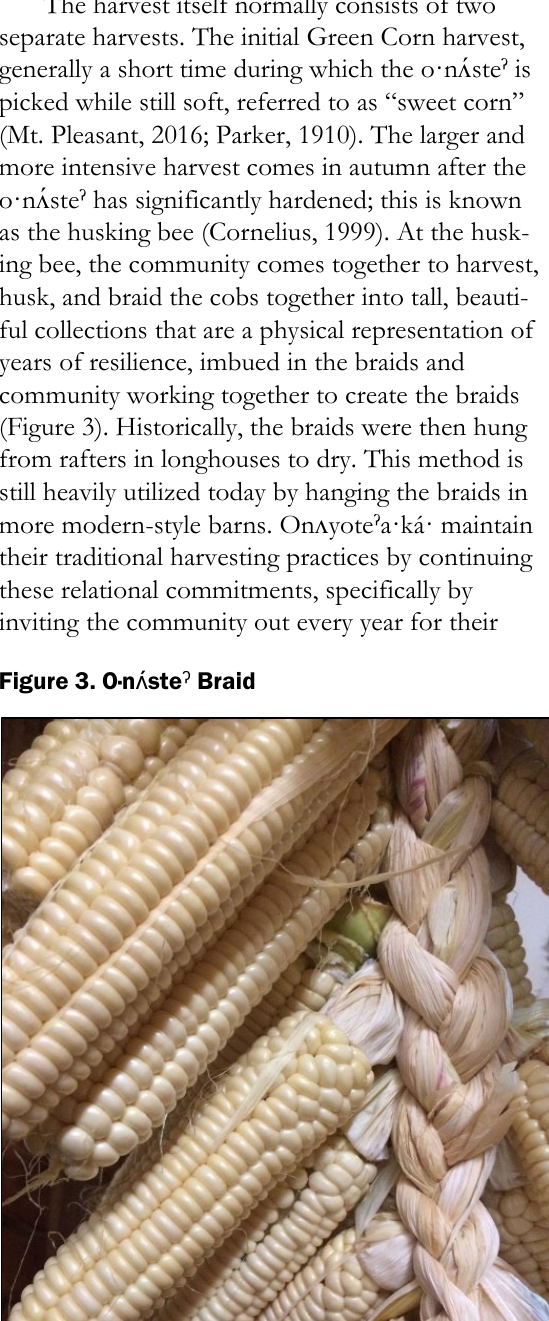
Photo courtesy of Rebecca